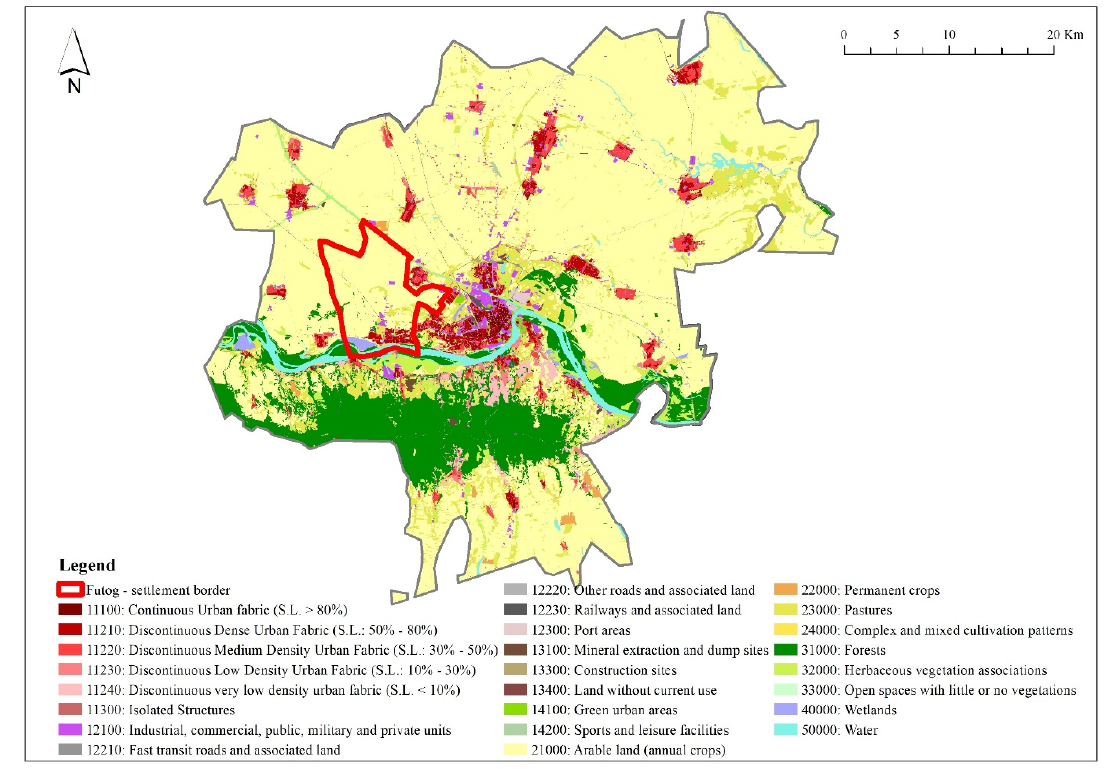
Figure 2. Land cover for Novi Sad FUA (2012).